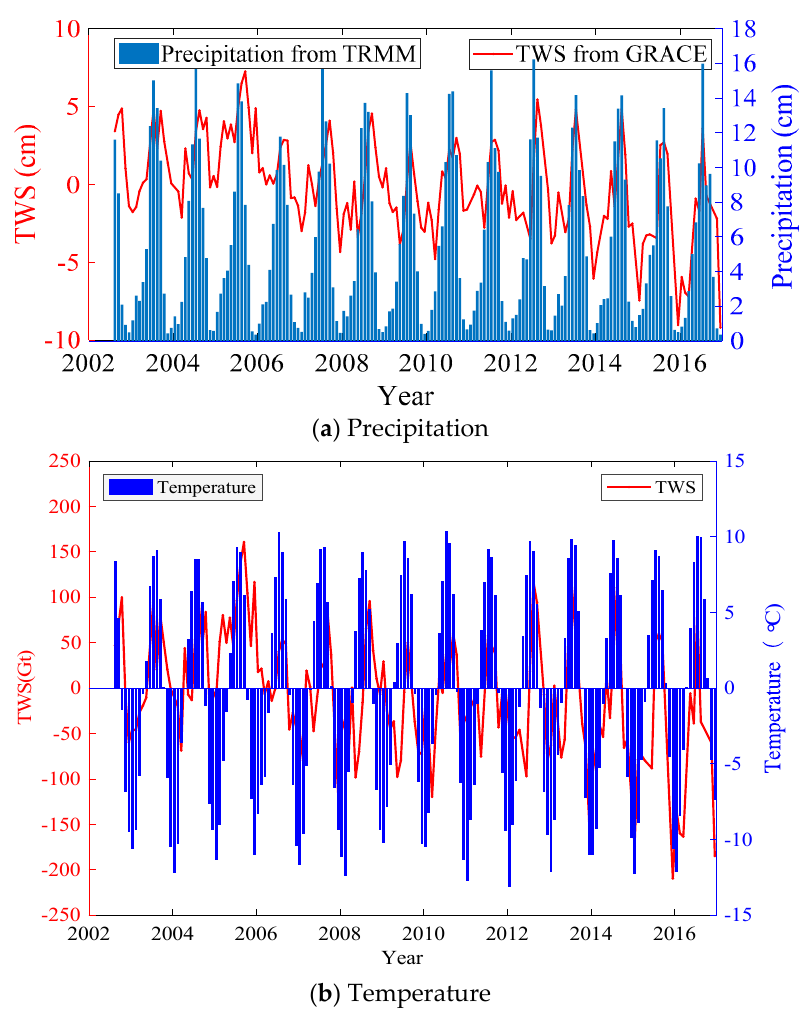
Figure 6. Time series of ( a ) precipitation and ( b ) air temperature versus water storage variations on the Tibetan Plateau from August 2002 to December 2016.